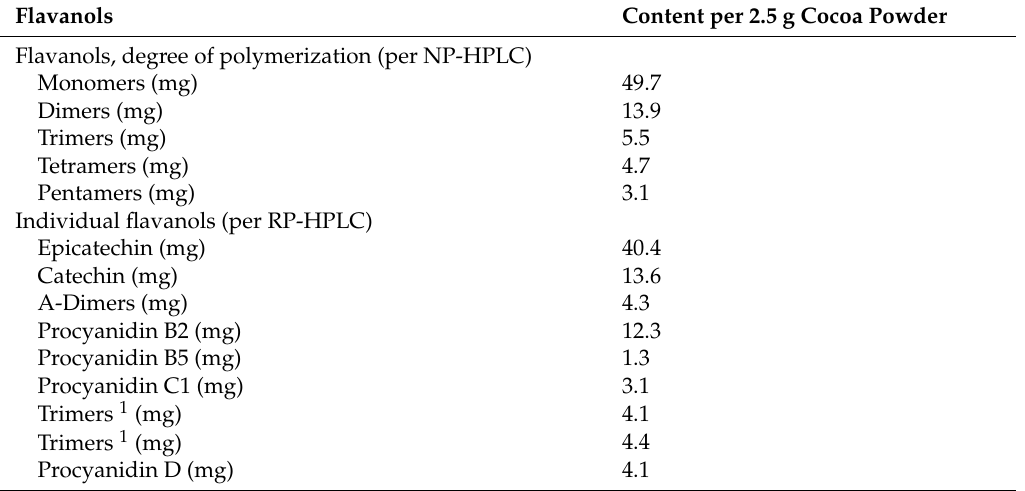
Table 2. Flavanol composition of the